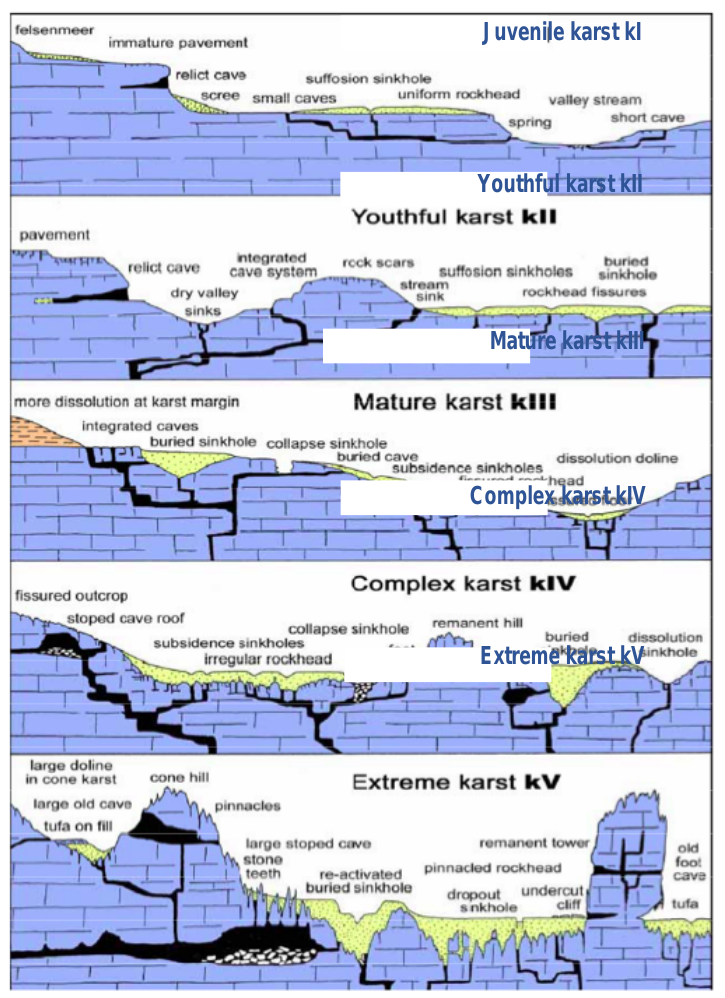
Figure 7. Typical morphological features of karstic ground conditions within five classes of the engineering classification of karst, modified from [29].